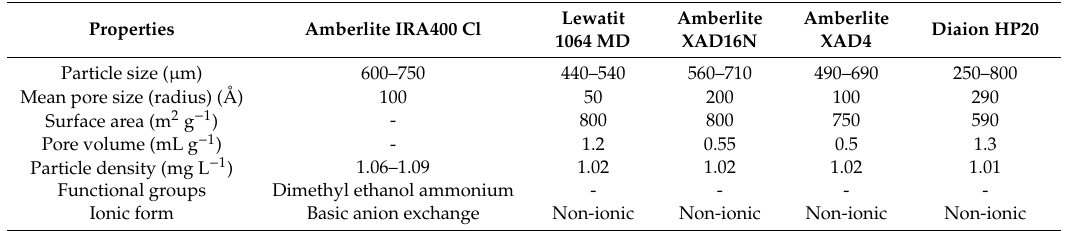
Table 2. Main properties of the polymeric adsorbers used for the in situ recovery of ( + )-zizaene 1 .